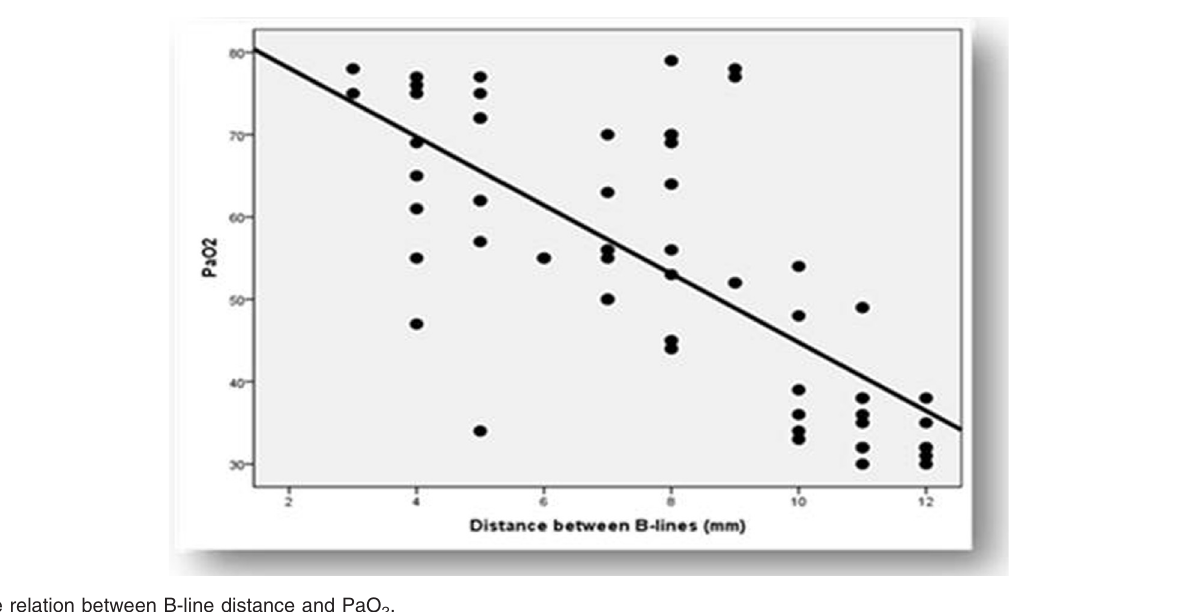
The relation between B-line distance and PaO 2 .